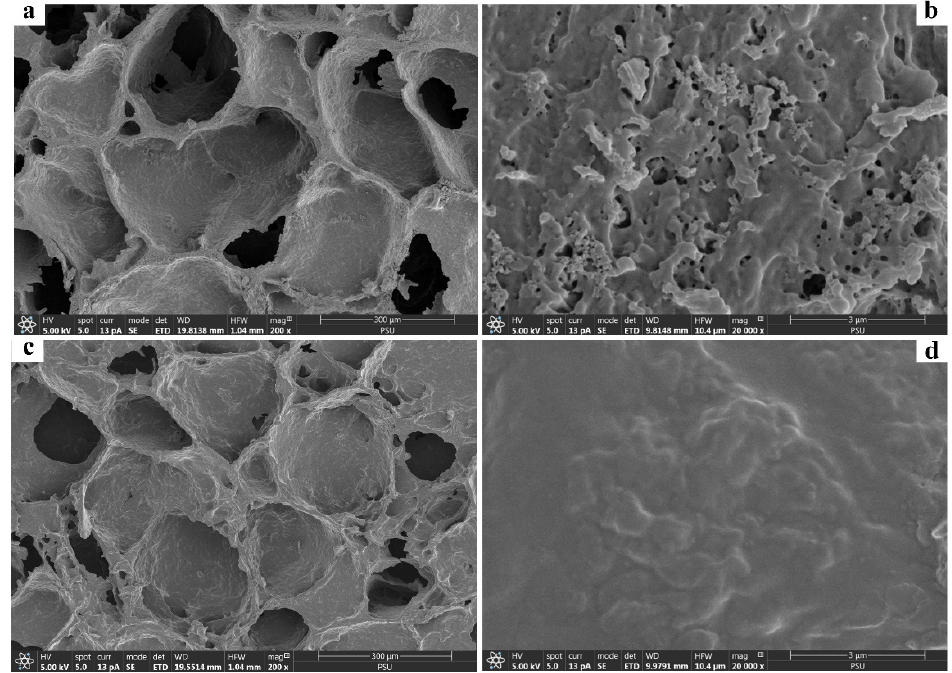
Figure 1. Field emission scanning electron micrographs of starch cryogel ( a , b ) before and ( c , d ) after adsorption of methylene blue.